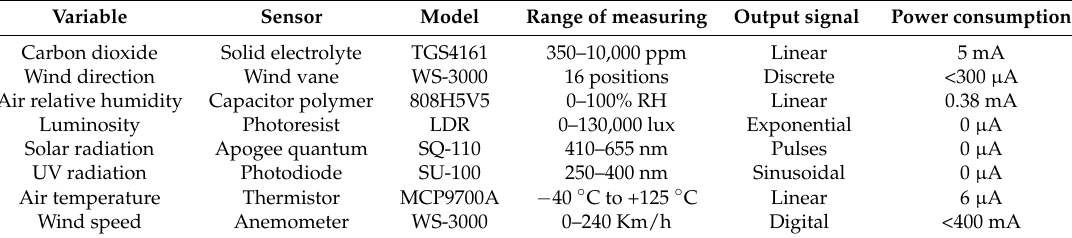
Table 3. Technical features of the used